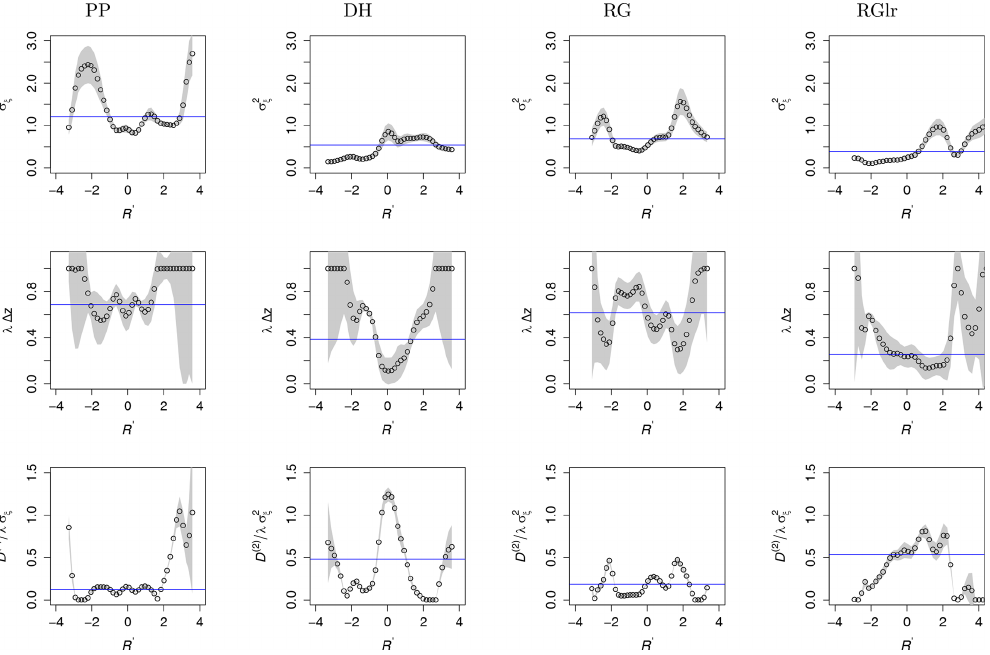
(R (cid:48) ) , jump probabilities λ(R (cid:48) ) (cid:49)z , and diffusion and jump ratios D ( 2 ) Figure 9. Jump amplitudes σ 2 ξ RG and RGlr (left to right). More data are present in the range of − 2 < R (cid:48) < 2; we focus our statistical analysis in this range with fewer uncertainties. The errors are shown as gray-shaded background. The ratios of diffusion and jump noise D near zero and maximum for DH and RGlr, which means that the larger the ice structure, the stronger the diffusion noise, and vice versa. The horizontal blue lines show the mean values of the respective parameters in the range of − 2 < R (cid:48) < 2.